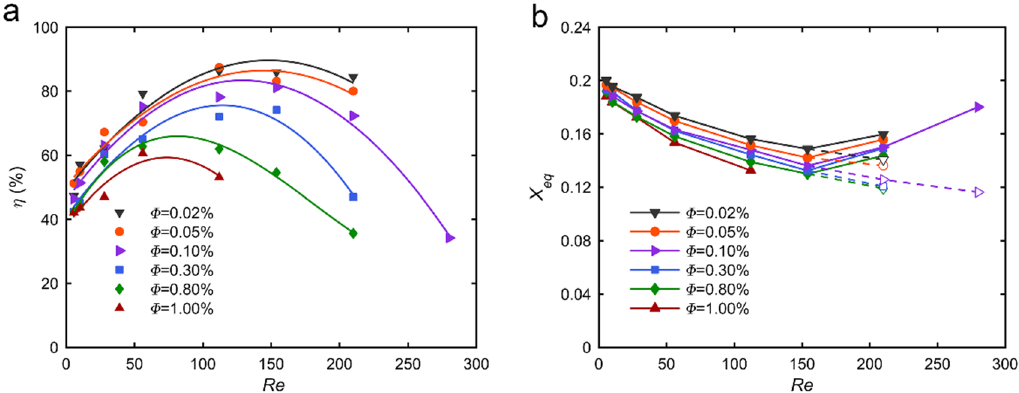
Figure 6. ( a ) Focusing degree and ( b ) equilibrium position with respect to Re at d p / H = 0.11, z / H = 1000, and different particle volume fractions. Solid lines correspond to the face-centered equilibrium positions, while the dashed lines indicate the newly-arisen equilibrium positions near the channel corners.